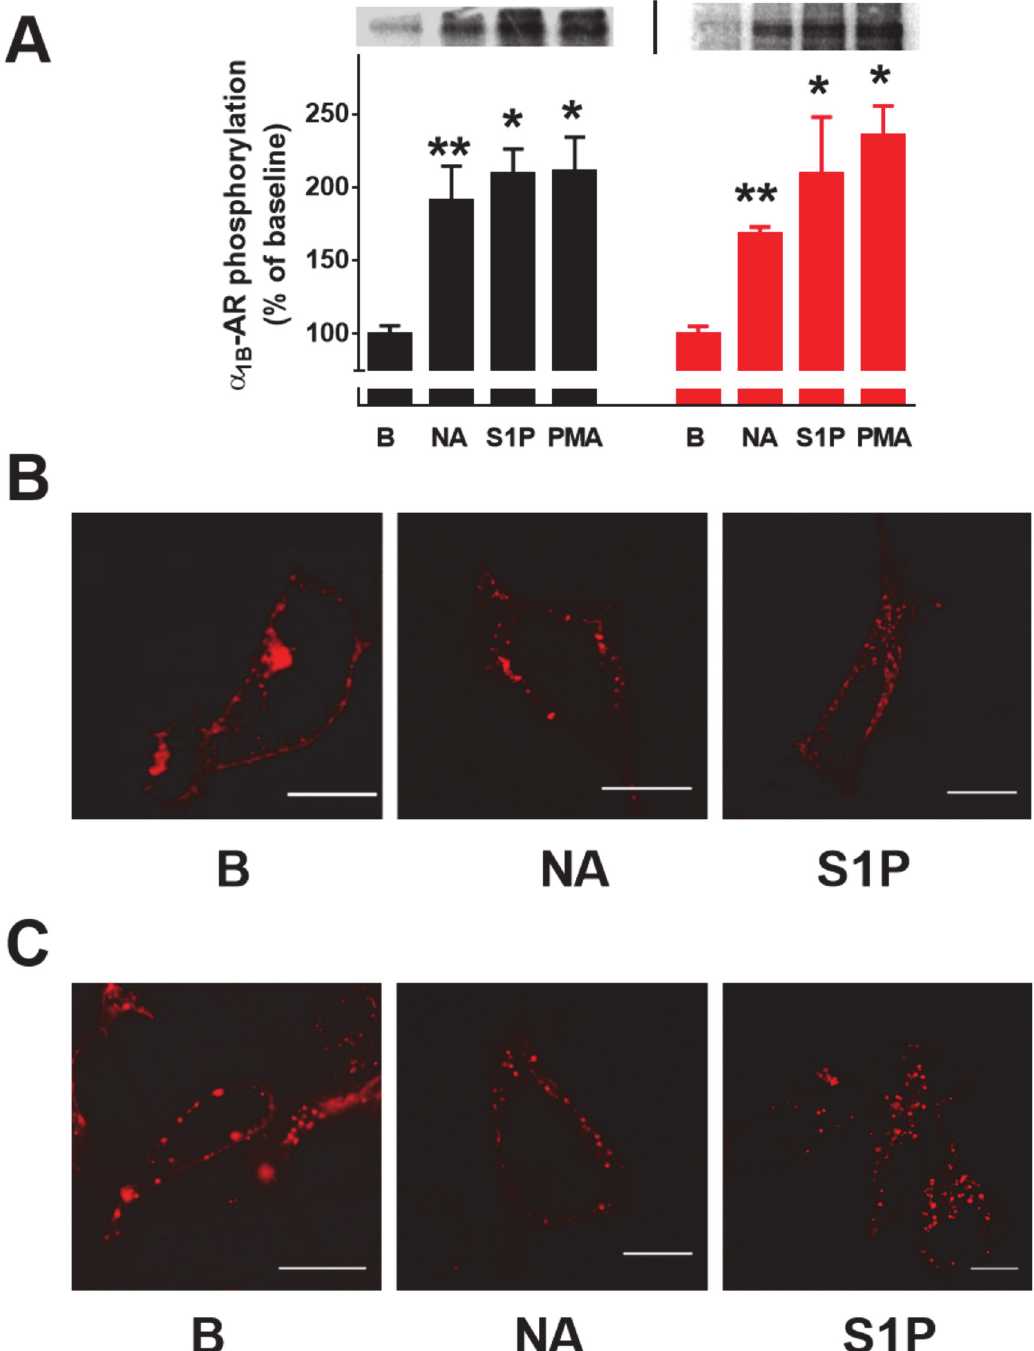
Fig 2. α 1B -Adrenergic receptor phosphorylation and internalization. Panel A: Cells expressing wild-type (black symbols) or DsRed-tagged (red symbols) human α 1B -adrenergic receptors were incubated in the absence of any agent (B, baseline, 30 min), 10 μ M noradrenaline (NA, 15 min) or 1 μ M sphingosine 1-phosphate (S1P, 30 min) to study receptor phosphorylation state. Plotted are the means and vertical lines representing the S.E.M. of 3 – 4 experiments using different cell preparations. * p < 0.005 vs. B (their respective cell line baseline value), ** p < 0.05 vs. B (their respective baseline value). Representative autoradiographs are presented. Panel B: Confocal microscopy images of cells expressing DsRed α 1B -adrenergic receptors incubated for 15 min in the absence of any agent (B, baseline), 10 μ M noradrenaline (NA) or 1 μ M sphingosine 1-phosphate (S1P). Panel C: Confocal microscopy images of cells expressing wild-type α 1B -adrenergic receptors incubated for 15 min in the absence of any agent (B, baseline), 10 μ M noradrenaline (NA) or 1 μ M sphingosine 1-phosphate (S1P). Scale bars: 15 μ m.